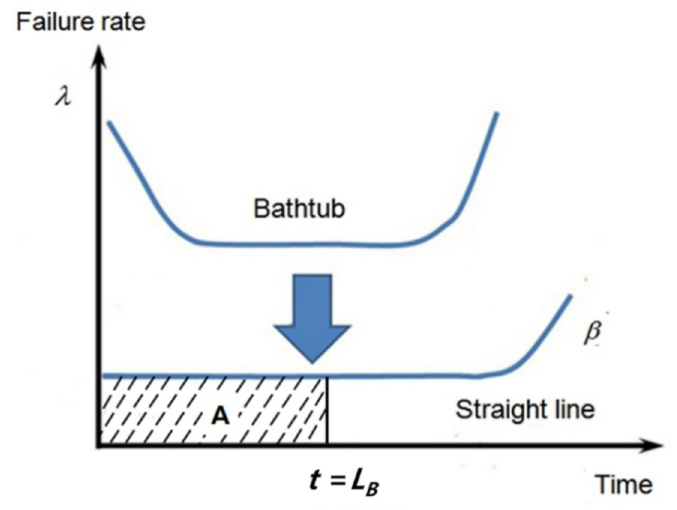
Figure 2. Bathtub curve and straight line.